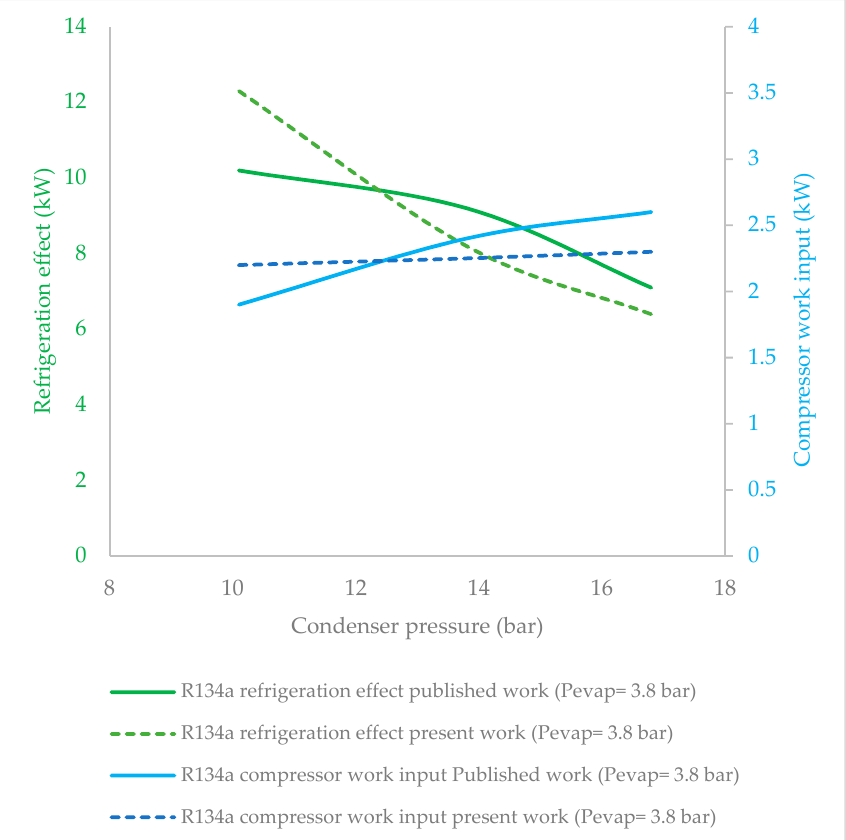
Figure 3. Error analysis of the results for the refrigeration effect and the compressor work input.